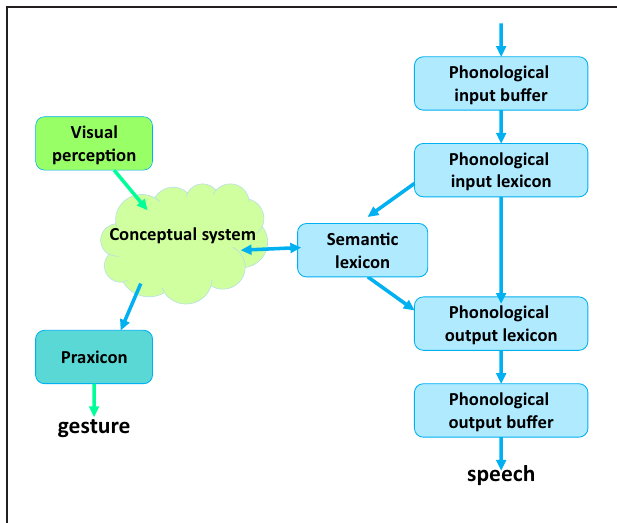
FIGURE 1 | Lexical processing